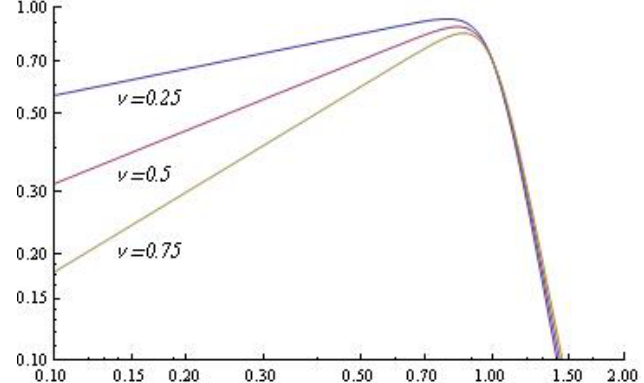
Figure 7. Modulus of the frequency response for the fractional Butterworth derivative with n = 7